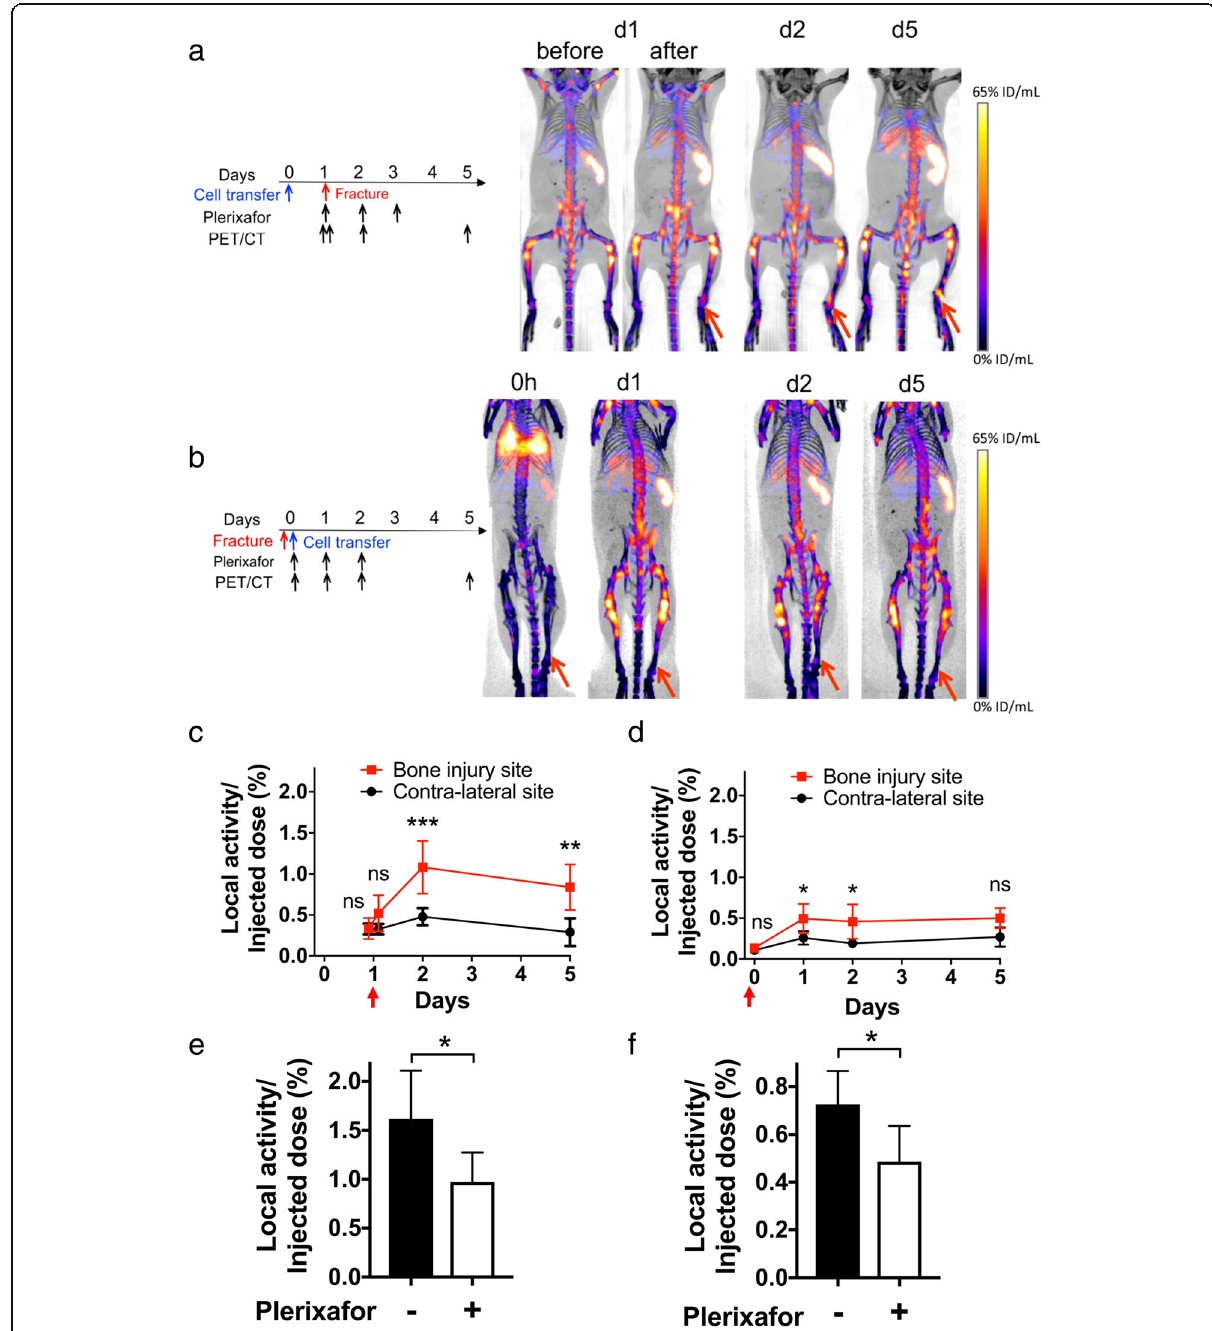
Fig. 3 Mobilization of BM cells using plerixafor reduces cell migration to the site of fracture. a The regimen of d1-fracture with a 3-day administration of plerixafor starting on day 1 and microPET/CT images are shown. 89 Zr-oxine-labeled BM cells trafficked to the fracture site and the accumulation was observed on day 2 through day 5 ( n =4). b The regimen of d0-fracture with a 3-day administration of plerixafor starting on day 0 and microPET/CT images are shown. The 89 Zr-oxine-labeled BM cells were transferred immediately after the fracture generation and administration of the first dose of plerixafor. Weak 89 Zr signal was observed at the injury site from day 1 through day 5 ( n =4). c Quantitation of the d1-fracture-plerixafor PET images indicate that the percentage of 89 Zr-labeled BM cells accumulated at the fracture was significantly higher than in the contralateral non-fractured tibia ( n =4). d Quantitation of the d0-fracture-plerixafor PET images show a slightly higher 89 Zr-labeled BM cells accumulation at the fracture compared to the contralateral tibia ( n =4). ( ns not significant, * p <0.05, ** p <0.01, *** p <0.001, two-way repeated measure ANOVA with Sidak ’ s test. The arrows indicate the timing of bone injury generation). e The peak accumulation on day 2 was reduced by plerixafor compared to non-mobilized mice in the d1-fracture-plerixafor scheme ( n =6). f Plerixafor significantly reduce the peak accumulation, on day 1 and 2, compared to the non-mobilized mice in the d0-fracture-plerixafor scheme ( n =6). (* p <0.05 with Mann-Whitney